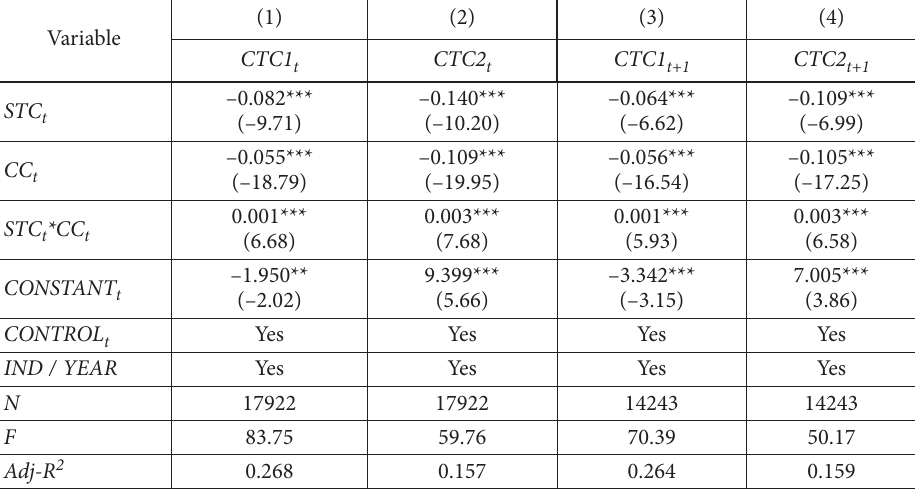
Table 5. Testing customer concentration’s mediating effect on the relation between supplier’s trade credit and customer’s trade